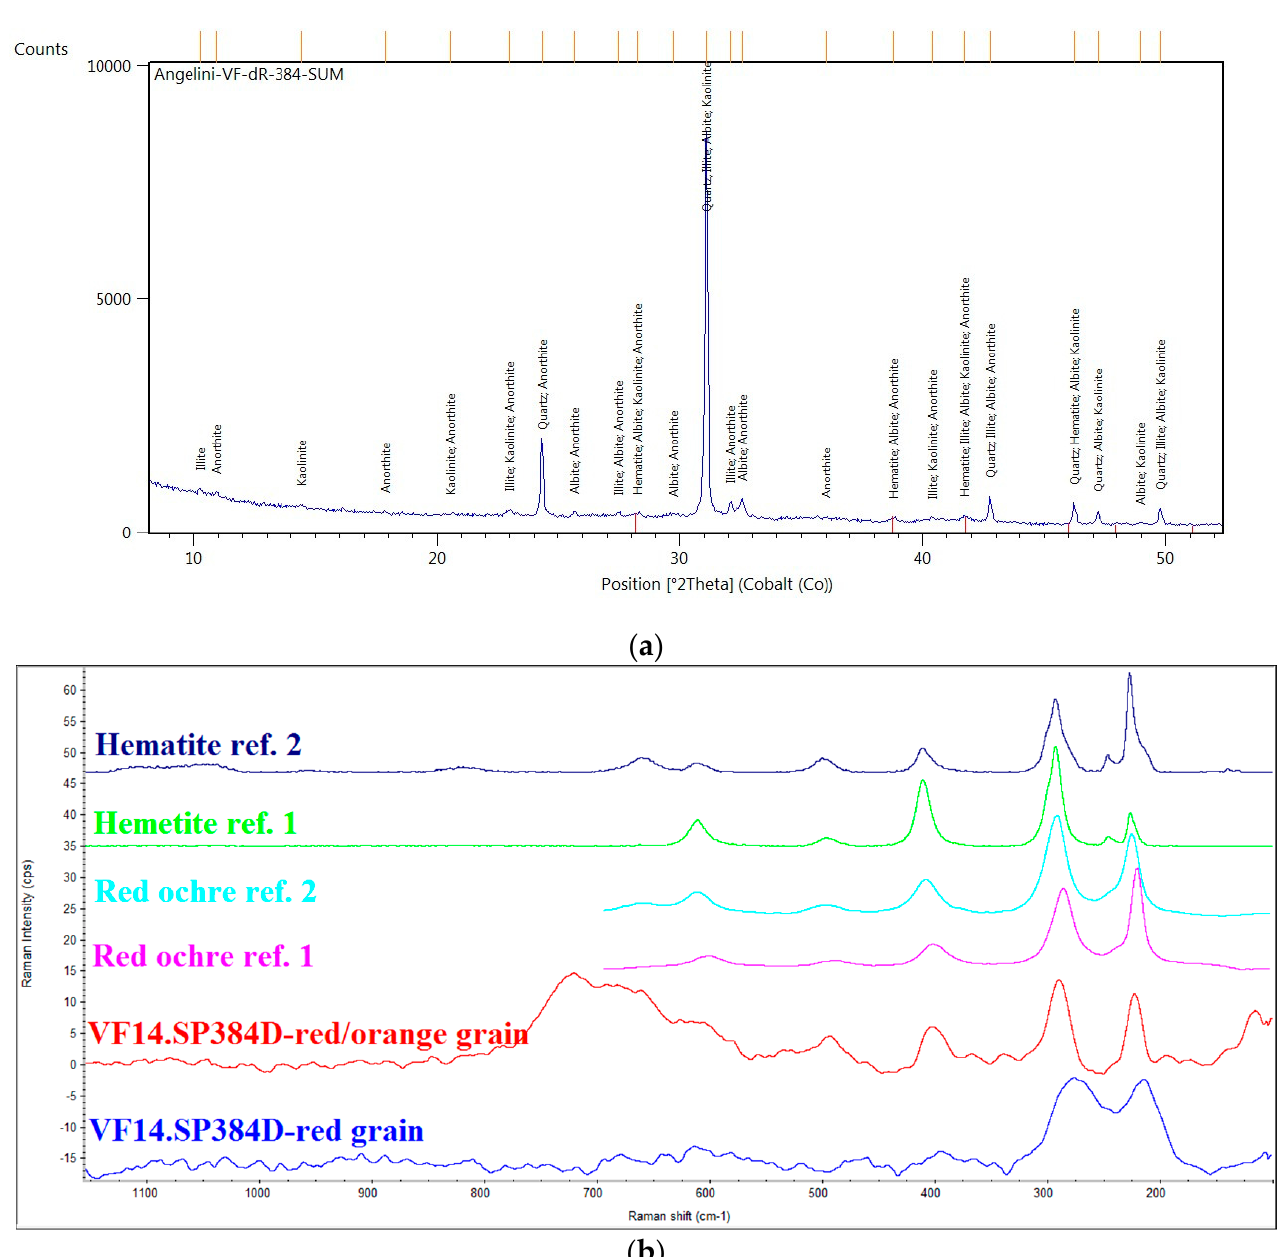
Figure 4. ( a ) XRPD diffractogram measured on the red coating of dice VF14.SP384D; ( b ) Raman spectroscopic signal of one red grain (blue spectrum) and one red-orange grain (red spectrum) present in the red coating of the same dice, compared with the spectra of two reference hematite (green and dark blue) and two red ochre samples (pink and cyan).